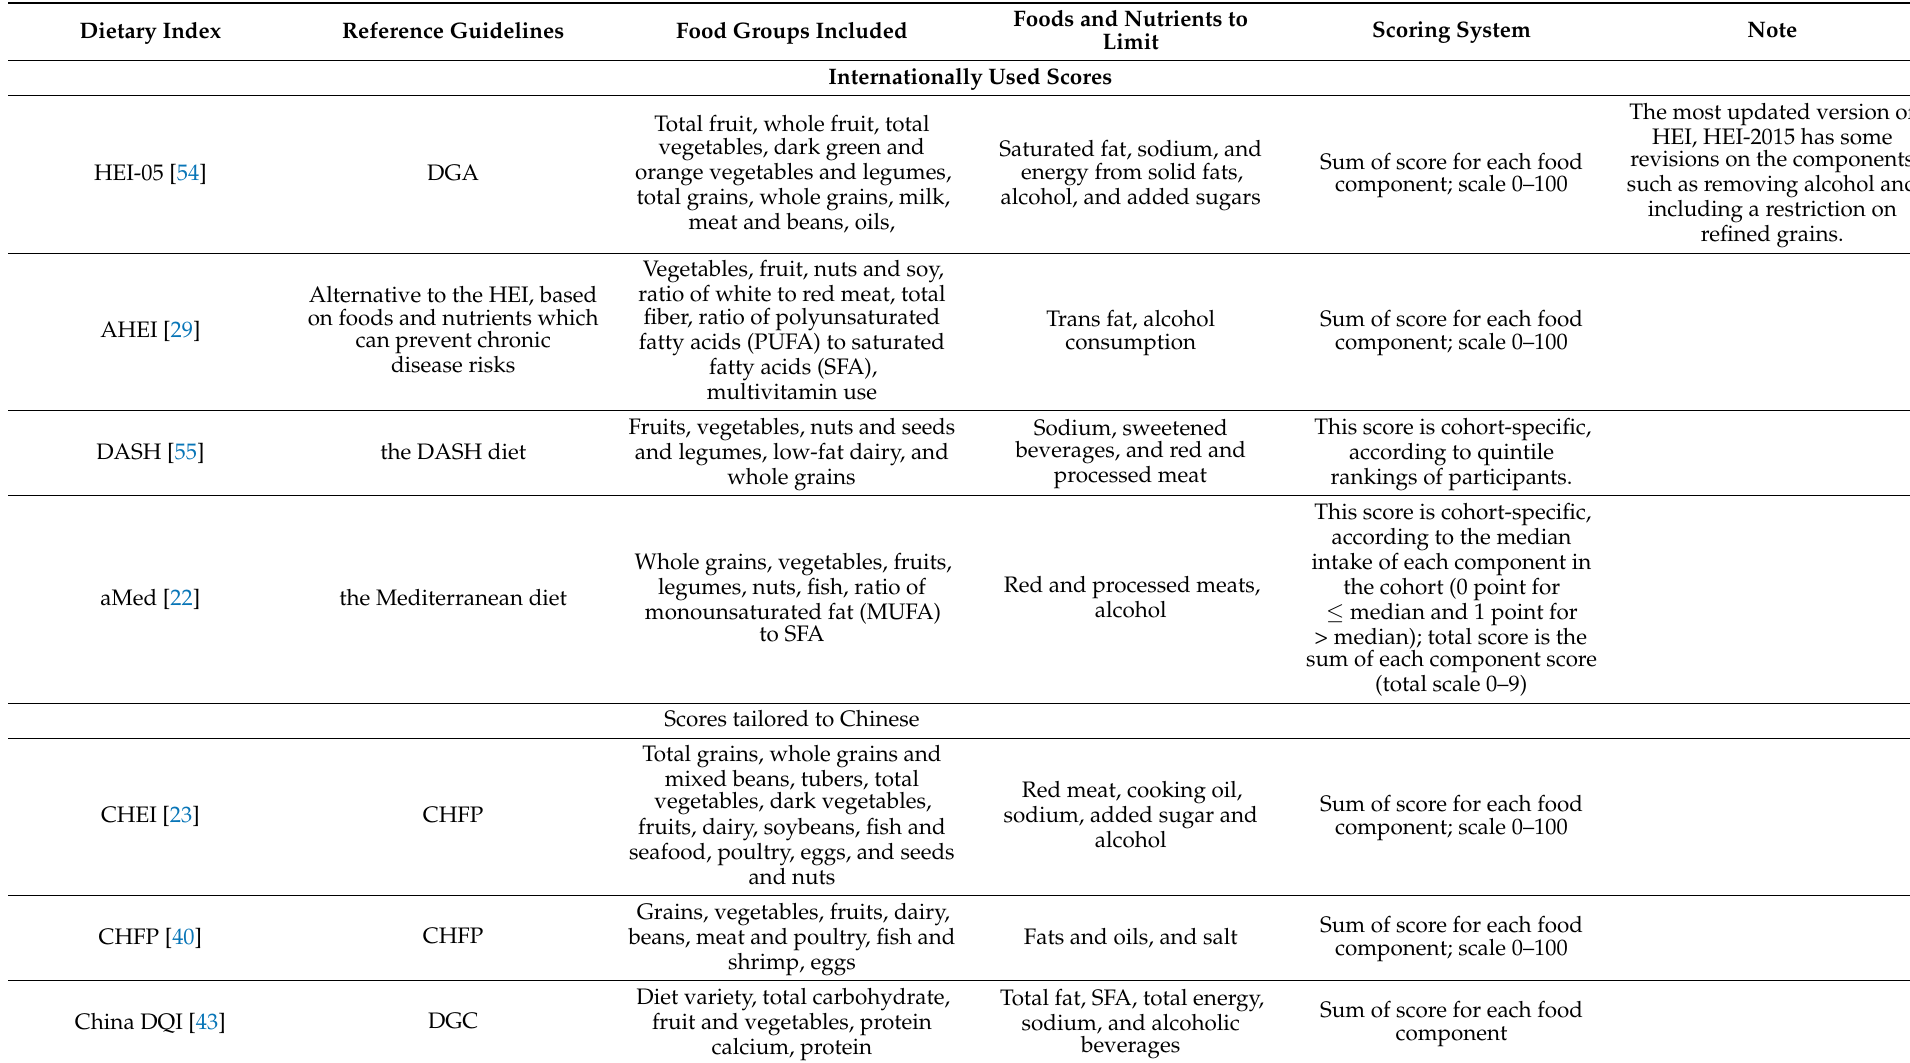
Table 2. Characteristics of different dietary